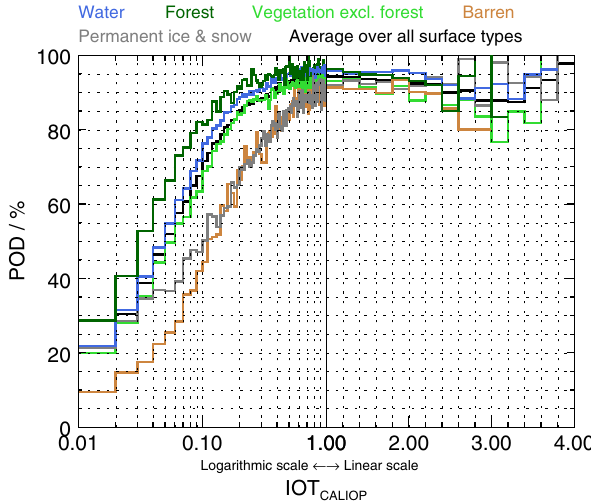
Figure 3. The cirrus POD of CiPS as a function of the IOT re- trieved by CALIOP for the five surface type classes. Note that the line colours correspond to the colours used in Fig.